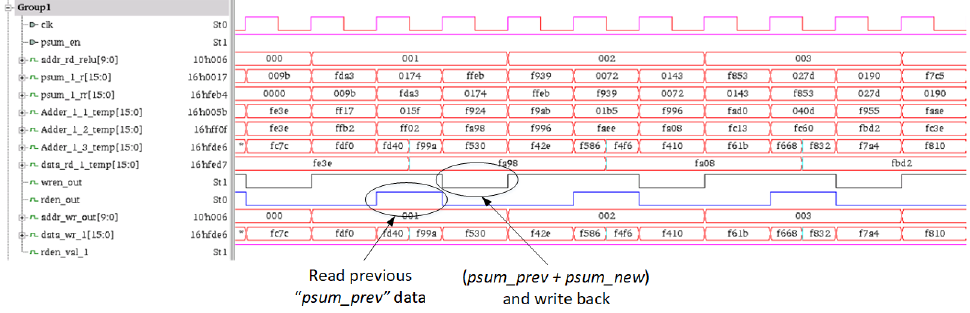
Figure 12. Simulation of ReLU hardware